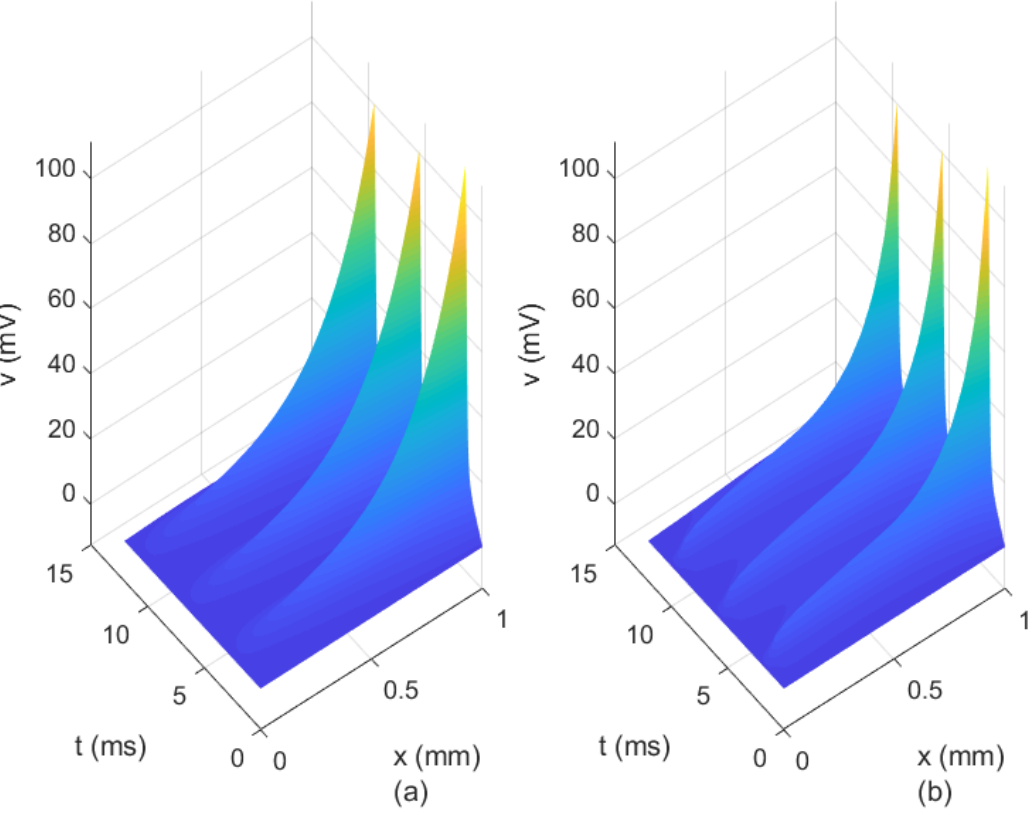
Figure 5. Spatio-temporal variations of voltage 𝒗(𝒙, 𝒕) for (a) 𝜶 = 𝟏 and (b) 𝜶 = 𝟎. 𝟔𝟓 .